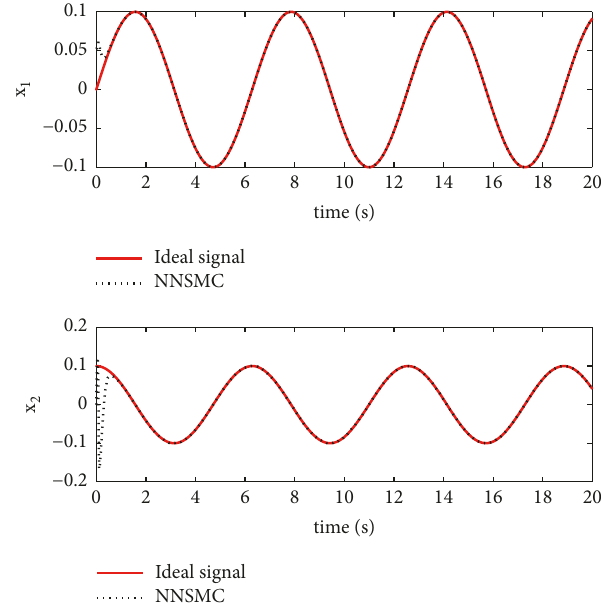
Figure 7: The tracking errors of NNSMC versus PID control.